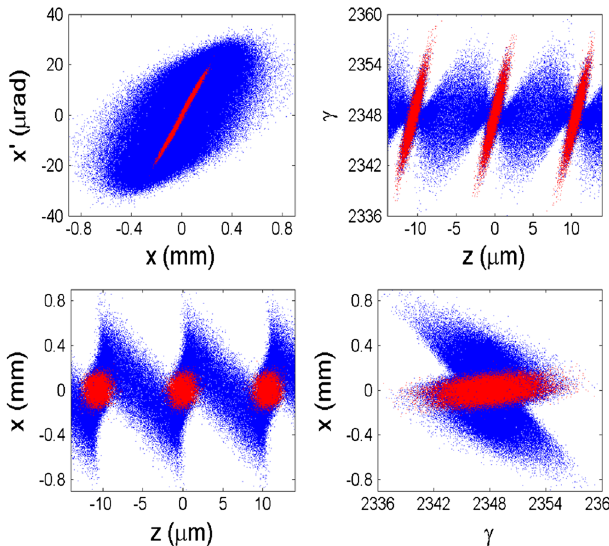
FIG. 3. (Color) Phase spaces after EE beam line (gold particles are marked by red color): (top left) x 0 vs x ; (top right) (cid:2) vs z ; (bottom left) x vs z ; (bottom right) x vs (cid:2)